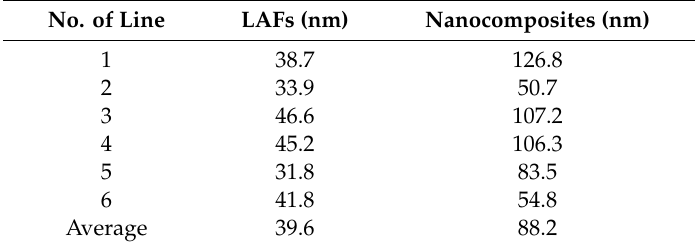
Table 1. Estimation of cross-sectional feature sizes of LAFs and